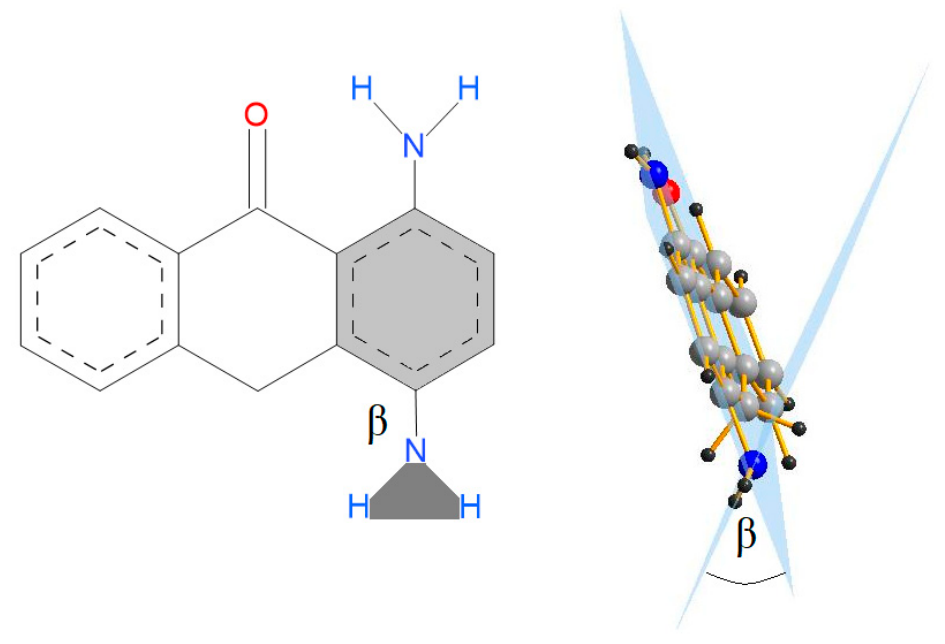
Table 1. α angle defined according to Scheme 2 for the investigated compounds. Angles for the optimized compounds (upper) and the angles for the crystal structure